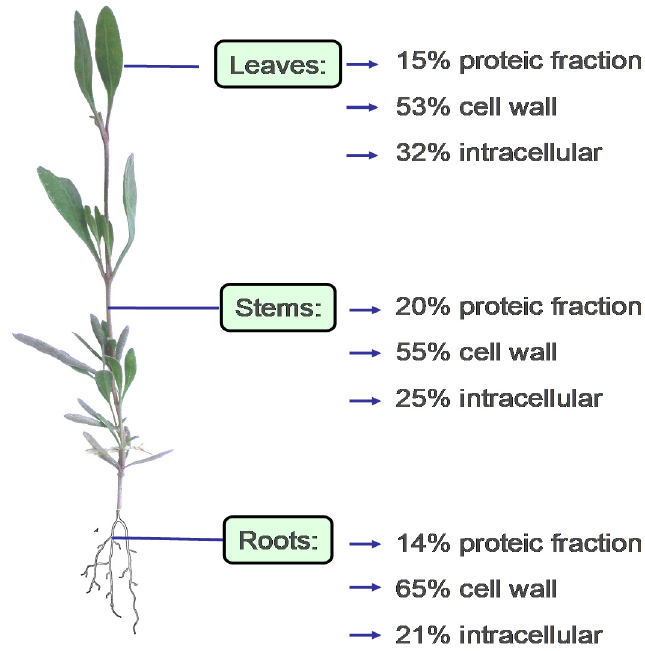
Figure 2. Metal distribution (leaves, stems, and roots) and compartmentation (cell wall, proteic fraction, and intracellular location) in A. portulacoides (redrawn and modified from Sousa et al. [35]).